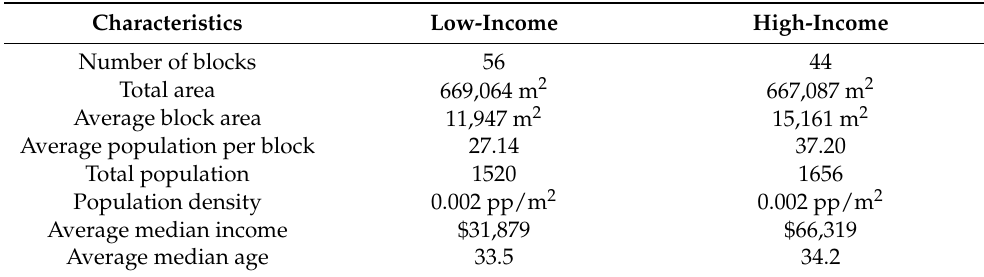
Figure 1. Study area in the Garden District neighborhood, Baton Rouge, LA, showing census block groups by median income, overlaying census blocks, key streets and adjudicated properties. Sources: adjudicated properties from Open Data Baton Rouge (2021); median income from the Amrican Community Survey (2017). Table 1. General characteristics of the neighborhoods sampled. Source: American Community Survey (2017), US Census (2010), and Open Data Baton Rouge (2021).